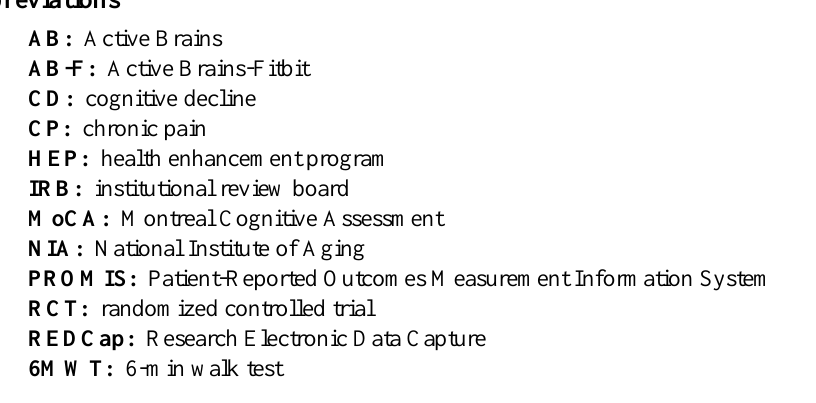
REDCap: Research Electronic Data Capture 6MWT: 6-min walk